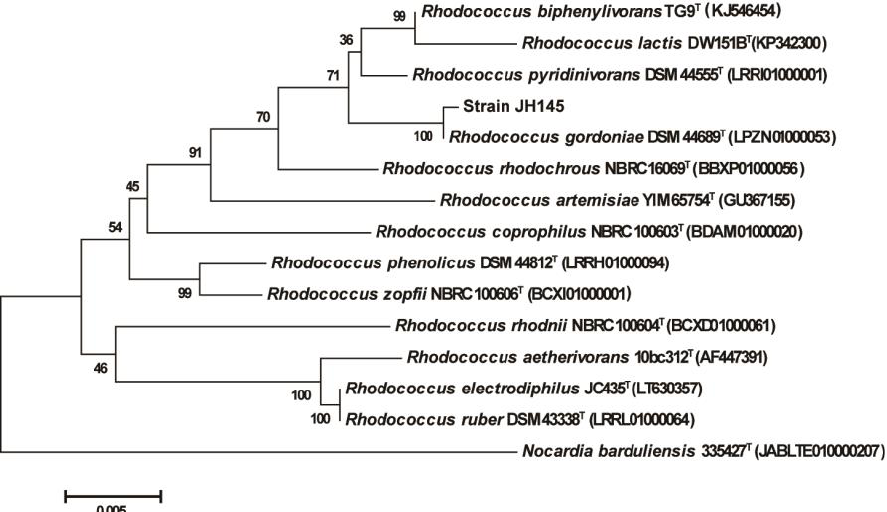
Figure 1. Phylogenetic tree constructed from the 16S rRNA sequence of strain JH145 and some other strains by the neighbor-joining method.